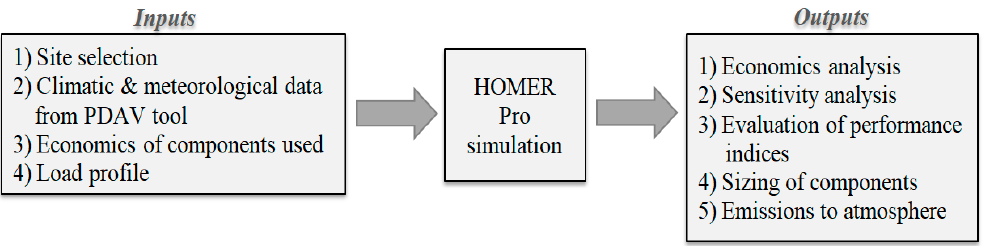
Figure 3. Flow chart of the HOMER Pro simulation tool.